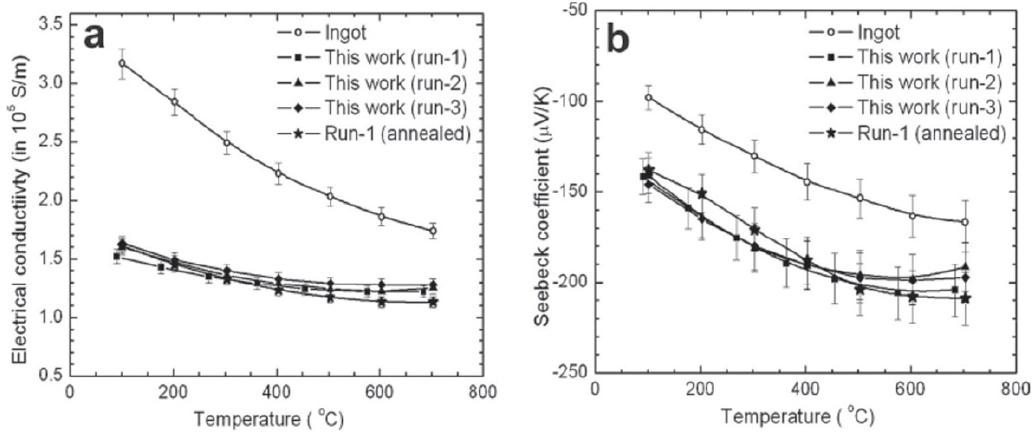
Figure 19. ( a ) Temperature-dependent electrical conductivity, ( b ) Seebeck coefficient, ( c ) power factor, ( d ) total thermal conductivity, ( e ) lattice thermal conductivity, and ( f ) ZT values of three nanostructured Hf Zr NiSn Sb samples, and the sample annealed 0.75 0.25 0.99 0.01 at 800 °C for 12 h in air; the line is for viewing guidance only, for comparison with the ingot sample (open circles) which matches the previously reported best n-type half-Heusler composition. Reproduced with permission from Reference [72]. Copyright 2011, John Wiley and